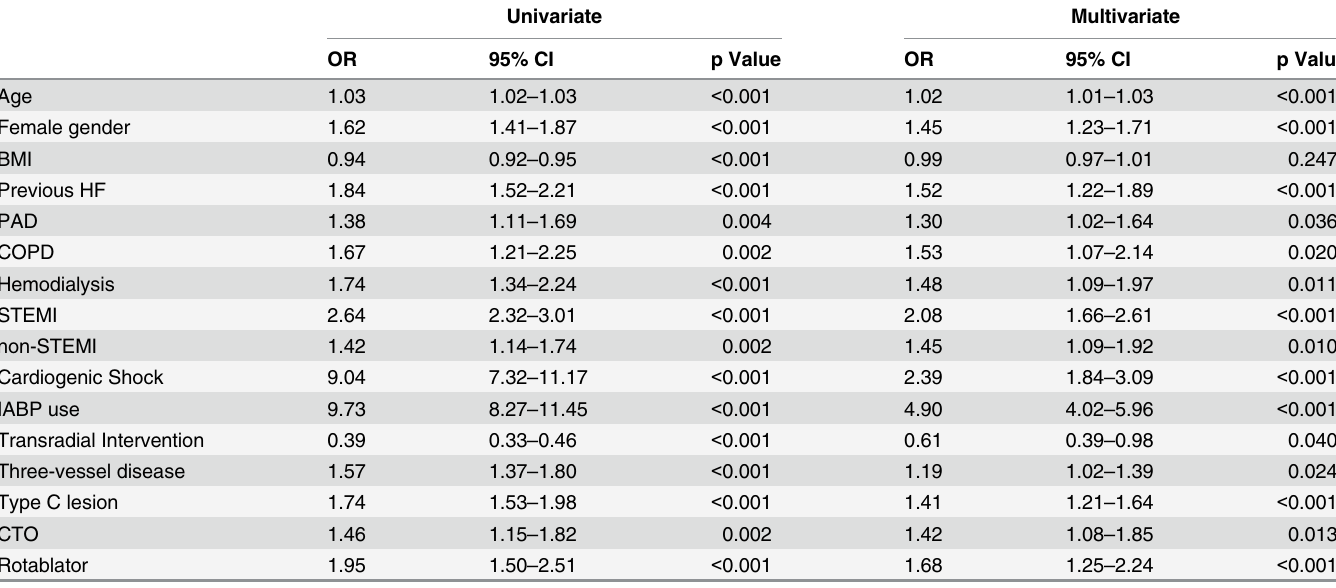
Table 4. Multivariate Logistic Regression Analysis on Overall Complications in the Total